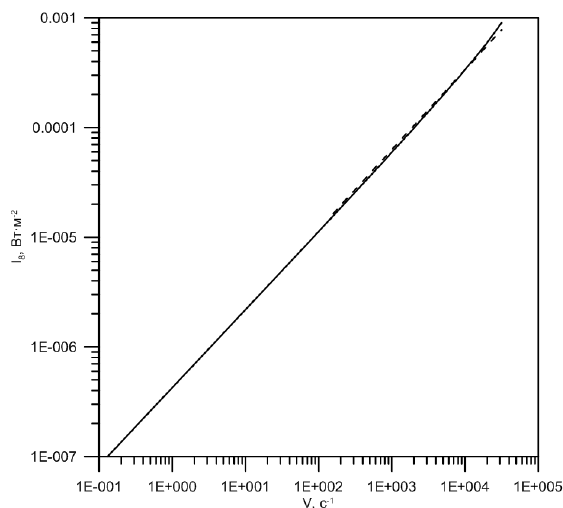
Fig. 3. Dependence of the flare point on the counting rate of the X-ray